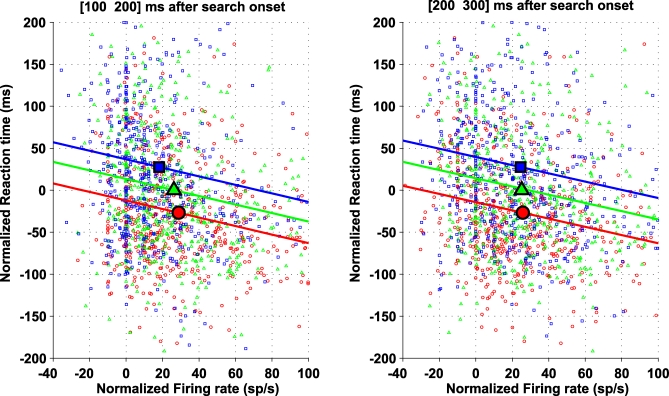
Correlation between Reaction Time and Firing Rates across Set SizesEach point shows the data from an individual trial (target in the RF), with data from all 50 neurons pooled together. For clarity of presentation only 50% of points (randomly selected) are depicted. Reaction times are normalized by subtracting each neuron's mean reaction time. Firing rates are normalized by subtracting each neuron's average firing rate (−200 to 300 ms after search onset, all correct target and distractor trials at all set sizes), which explains why firing rates are shifted toward positive values. Filled symbols show the average reaction time and firing rates for each set size. Lines are best-fit solutions using ANCOVA (see text).